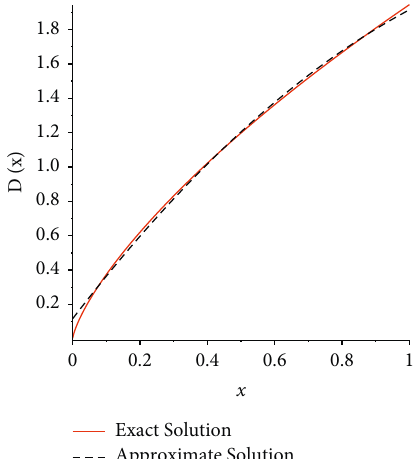
Figure 1: Comparison of the exact solution and approximation for L ( x ) . 1